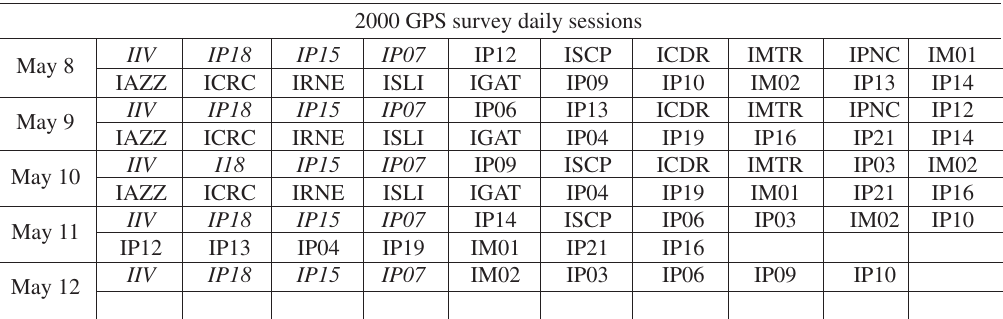
Table III. Schedule of daily sessions of the 2000 survey. The higher redundancy in station occupations, with respect to the 1998 survey, is due to the higher number of available GPS receivers. 2000 GPS survey daily